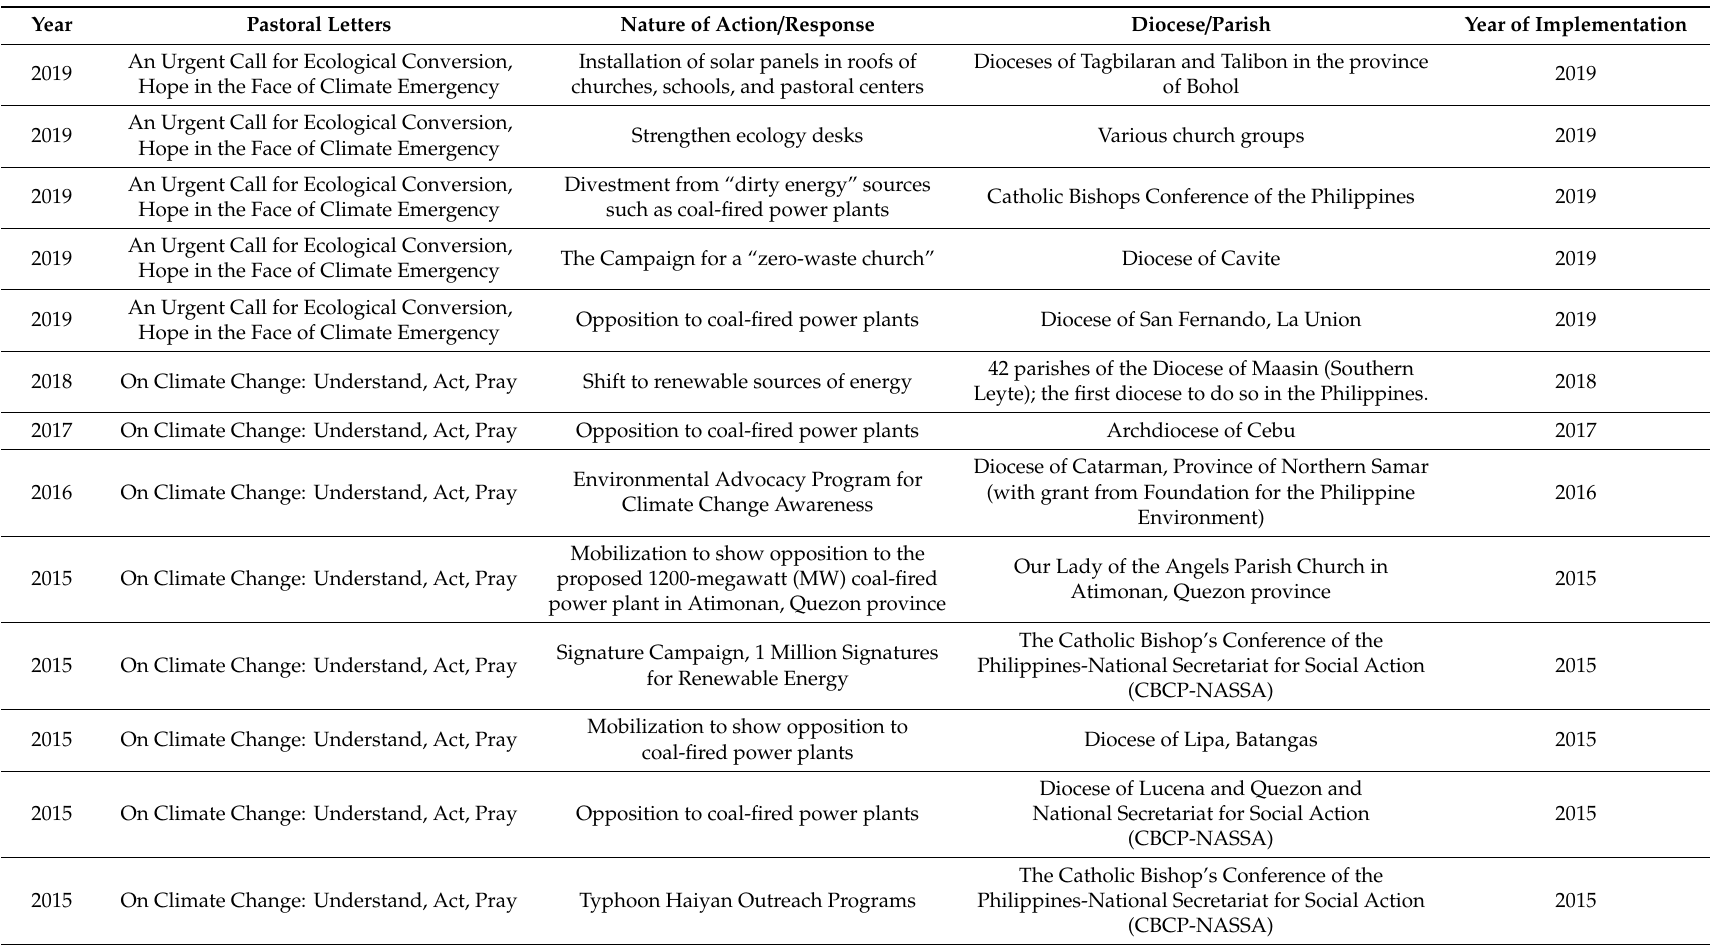
Table 1. Concrete responses to pastoral letters on climate change (2015 to